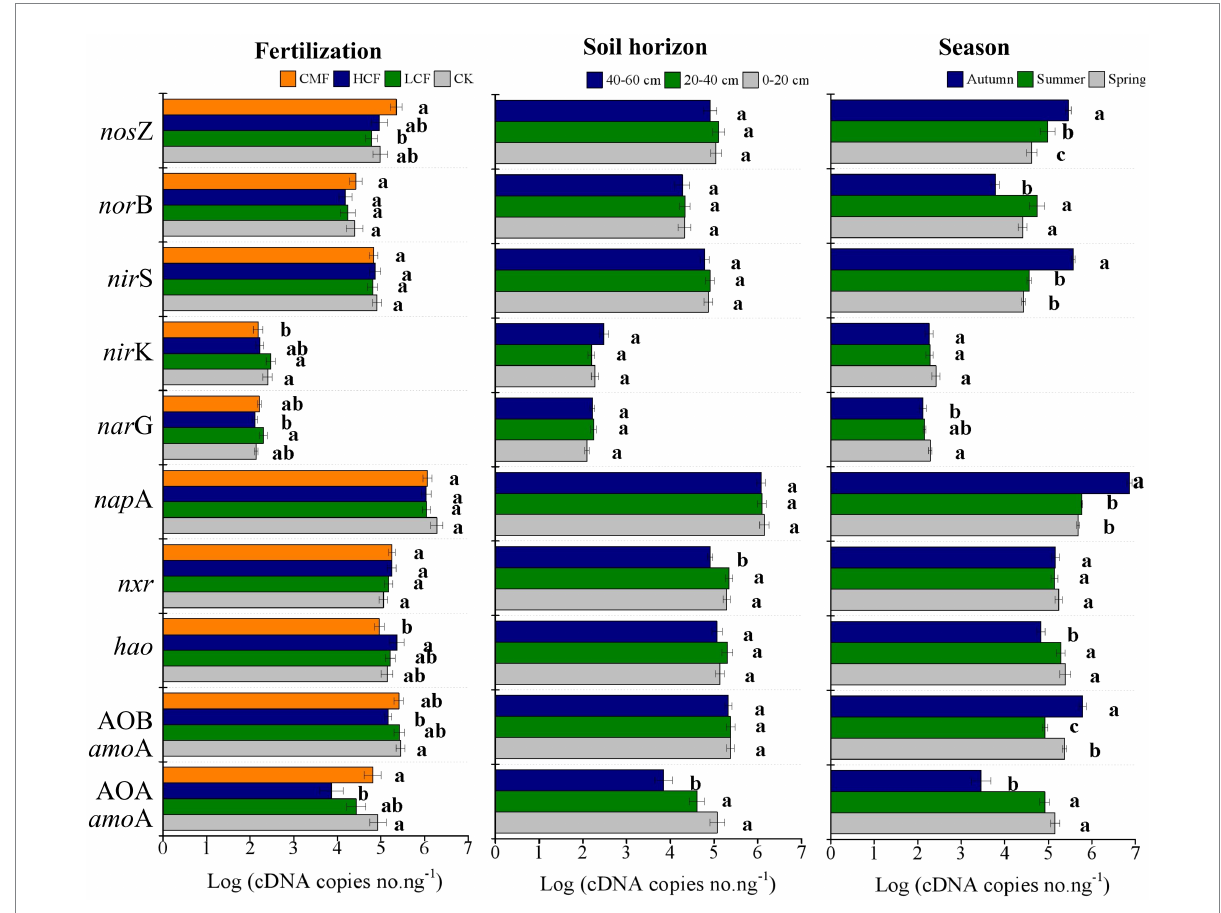
FIGURE 1 Variation in active genes in nitrification and denitrification as influenced by fertilization, soil horizon, and season. The letters represent significant differences at p ≤ 0.05 according to the LSD multiple comparisons test in different treatments. CK, control without fertilizers; LCF, low N chemical fertilizer; HCF, high N chemical fertilizer; and CMF, manure fertilizer combined with N chemical